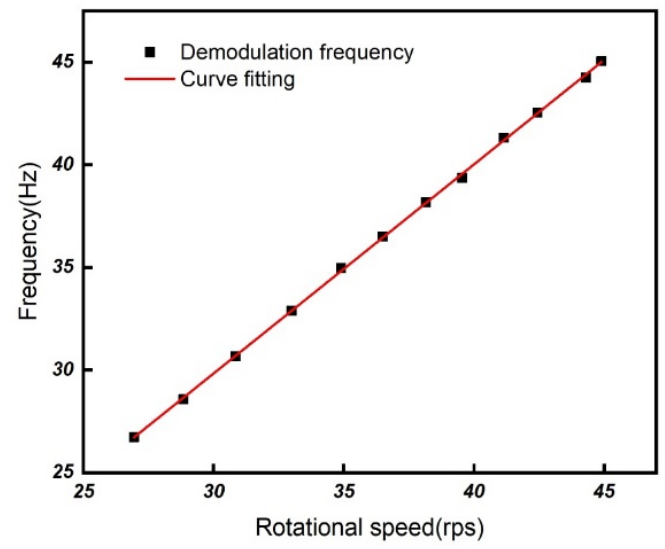
Figure 9. The measured output frequency as a function of rotational speed obtained by the LED detection method.